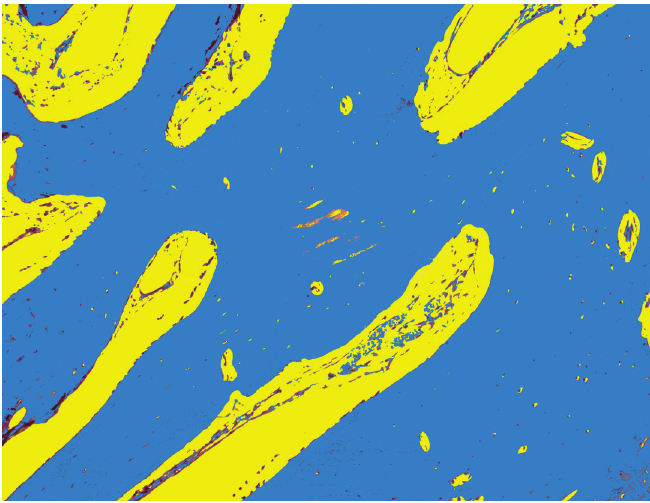
FIGURE 2 - The same histologic section prepared for histometry. The bone tissue was marked in blue and the soft tissue in yellow. Then the percentage of bone tissue was measured using the Image Pro Plus